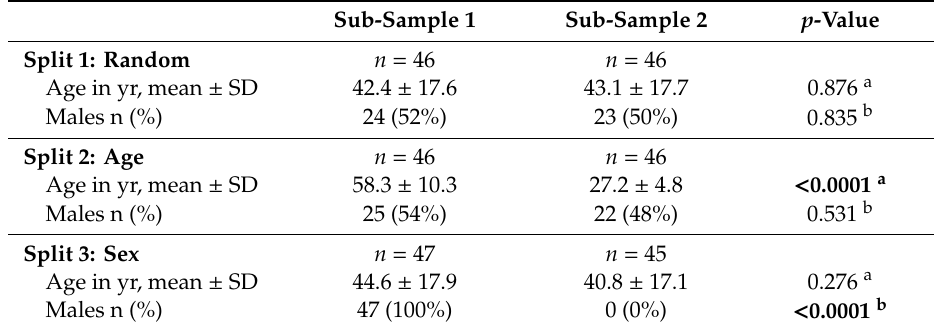
a = Mann–Whitney Independent Samples Test; b = Chi-square Test. Significant p -values are highlighted in bold. Legend: n = number, yr = years, SD = standard